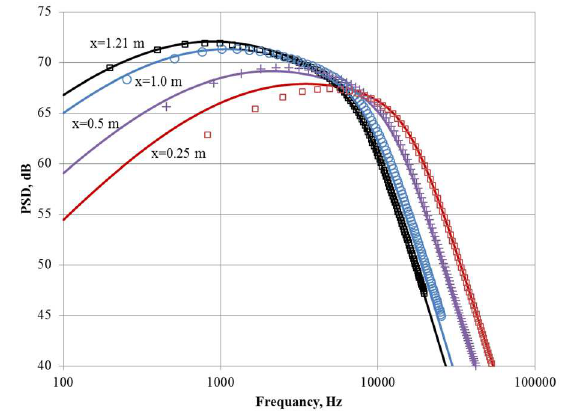
Fig. 10. Power spectral density at the points along the flat plate. Solids lines – current model, symbols – model [8].